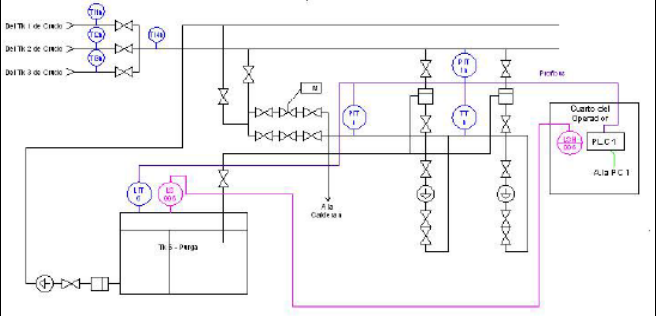
Figura 9: Configuración de los lazos y la red Profibus de las bombas de primer impulso. Fuente: Los Autores, (2015).